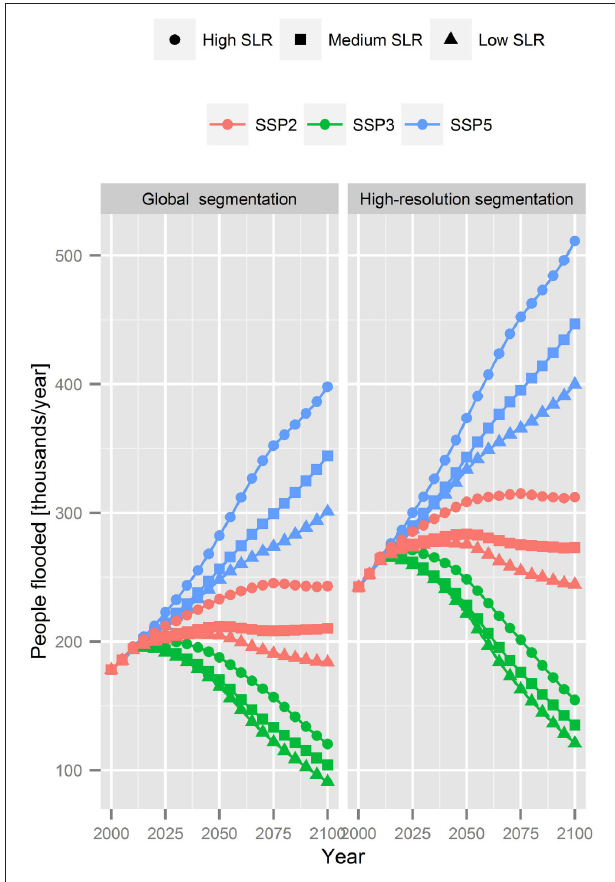
FIGURE 6 | Average annual people flooded from 2000 to 2100 under all SLR scenarios.